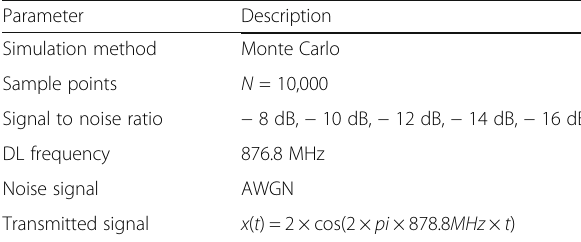
Table 2 Energy detector simulation parameters